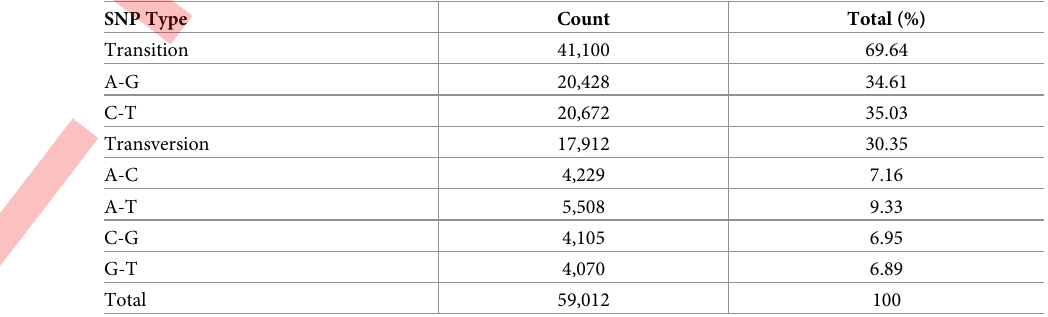
Table 5. Summary of SNPs (single nucleotide